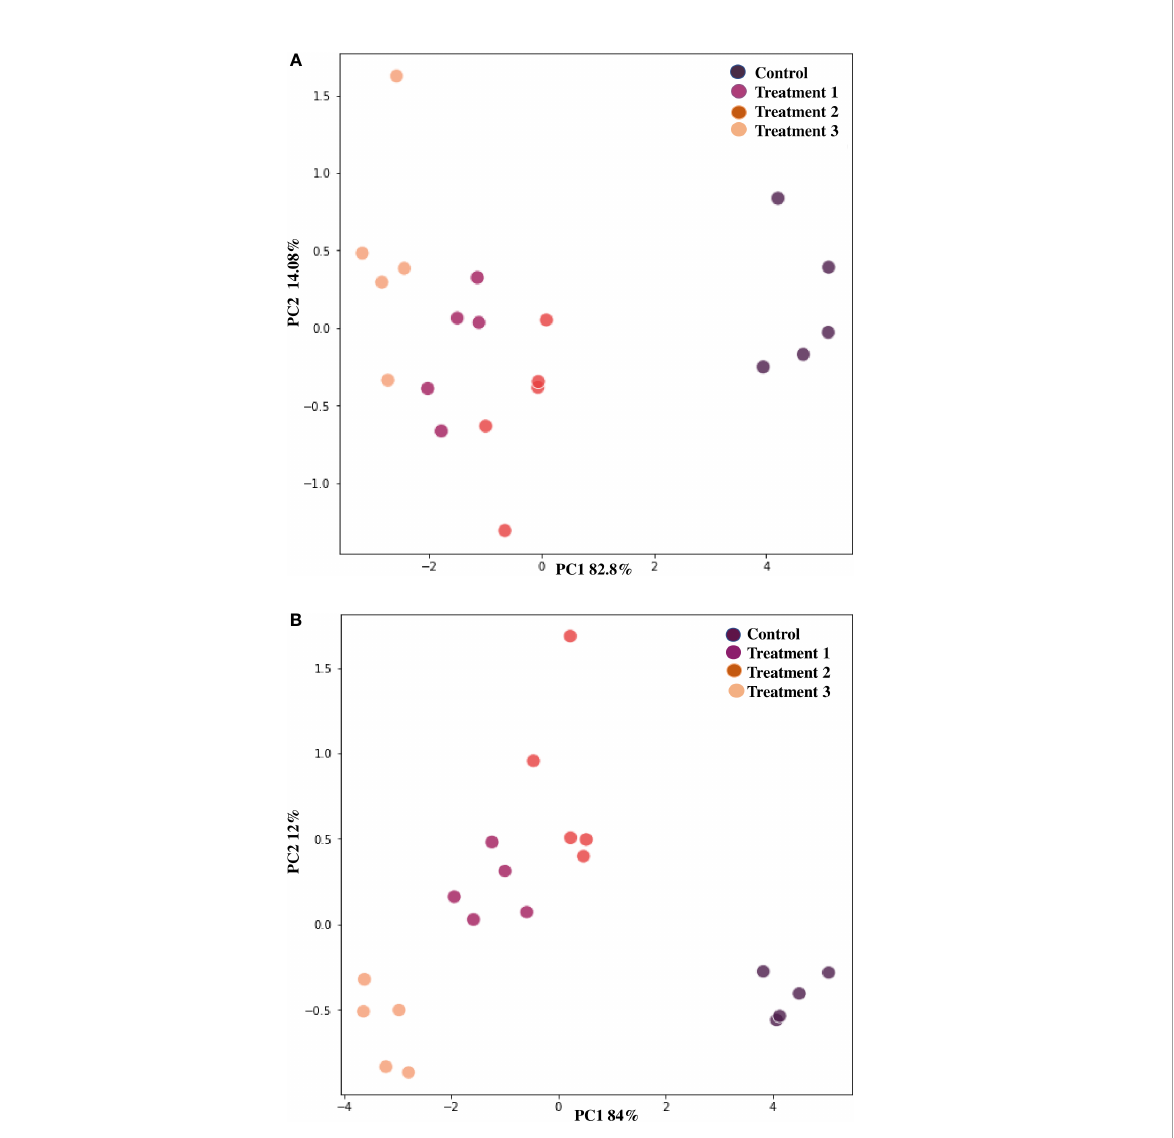
FIGURE 9 Principle component analysis based on the eigen values in a matrix on the PGP datasets to study the correlation between growth parameters and endophytic actinobacterial treatment in the PGP experiment. (A) After 35 days and (B) After 70 days of treatment. PCA resulted in two major principal components (PC), PC1 and PC2, on reduction of the dimension of the various PGP parameters. PC1 indicates the highest variance in the dataset with 82.8% (35 days), 84% (70 days), and PC2 shows the lowest variance in the dataset with 14.08% (35 days) and 12% (70